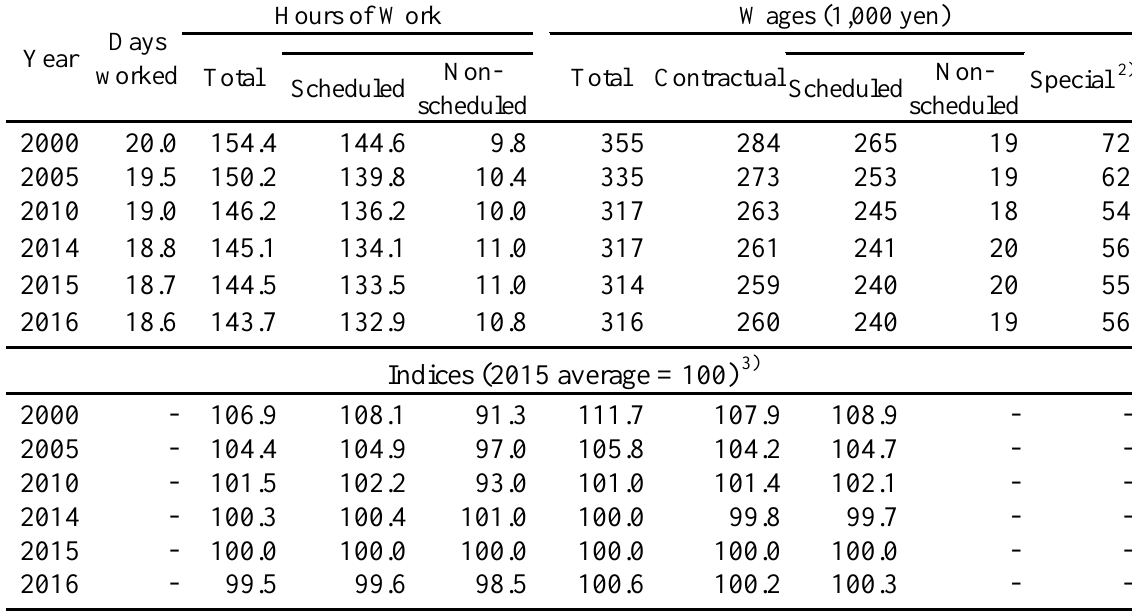
Hours of Work and Wages 1) (Monthly